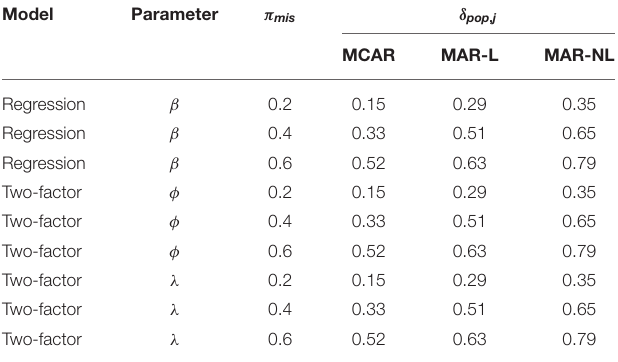
TABLE 2 | The bias, RMSE, and the 95% equal-tailed interval width of the regression coefficient FMI estimate ( ˆ δ β